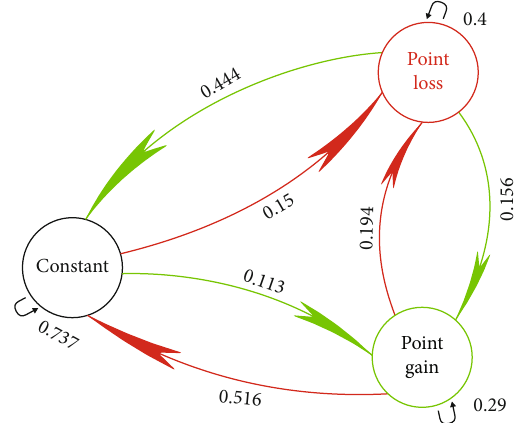
Figure 12: Standard Chartered Bank equity transition matrix and diagram.